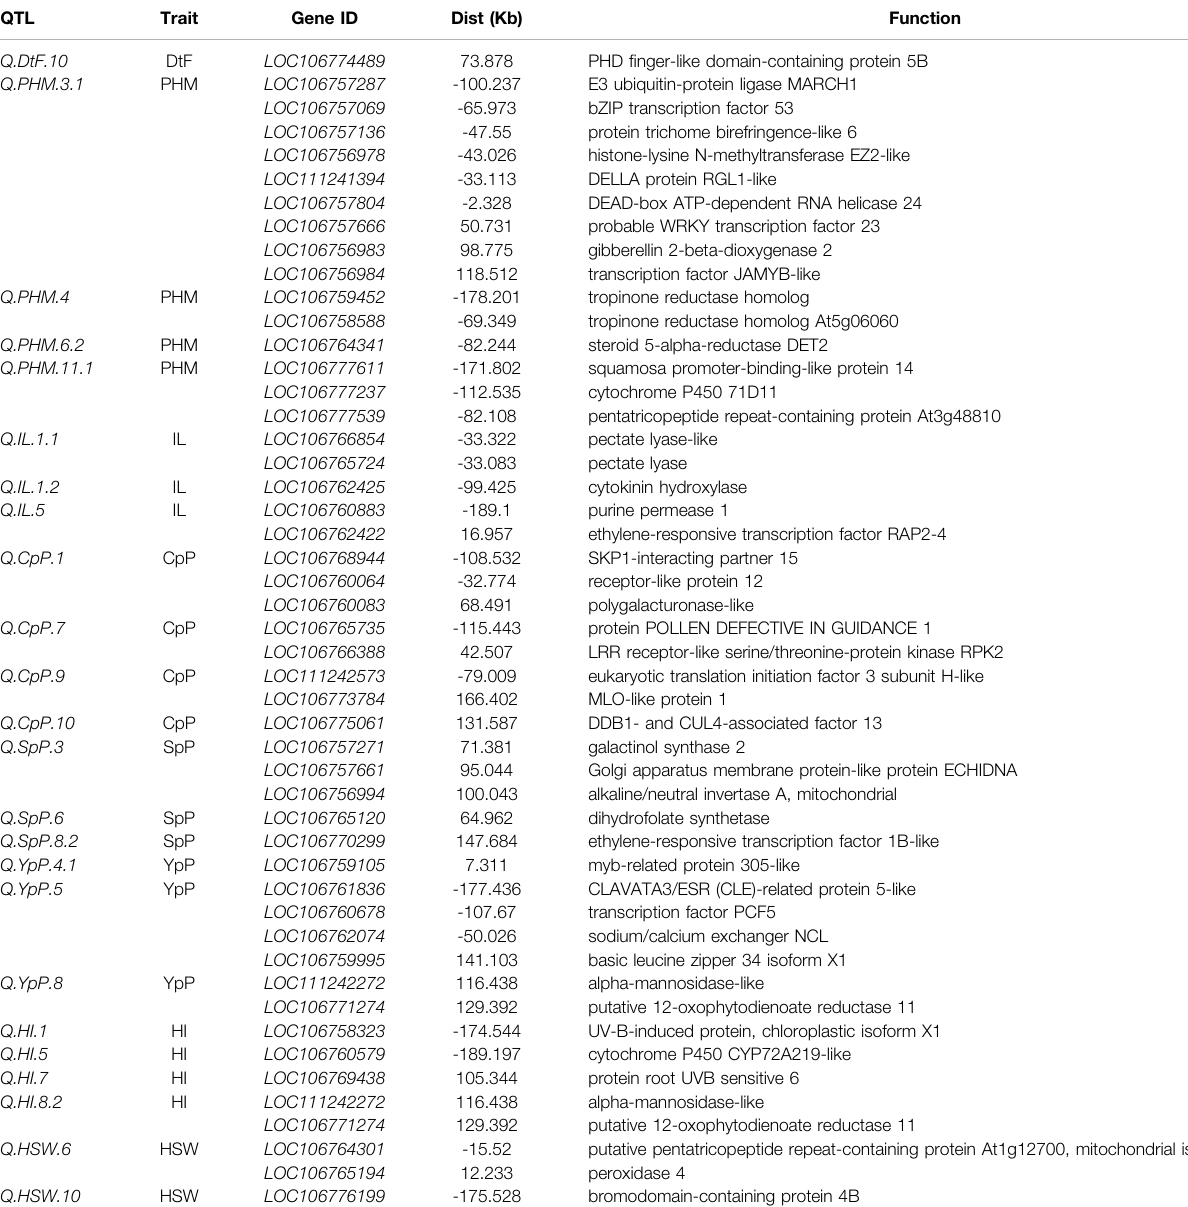
TABLE 3 | List of candidate genes with their previously reported biological pathway function obtained in the putative QTL regions. QTL Trait Gene ID Dist (Kb) Function